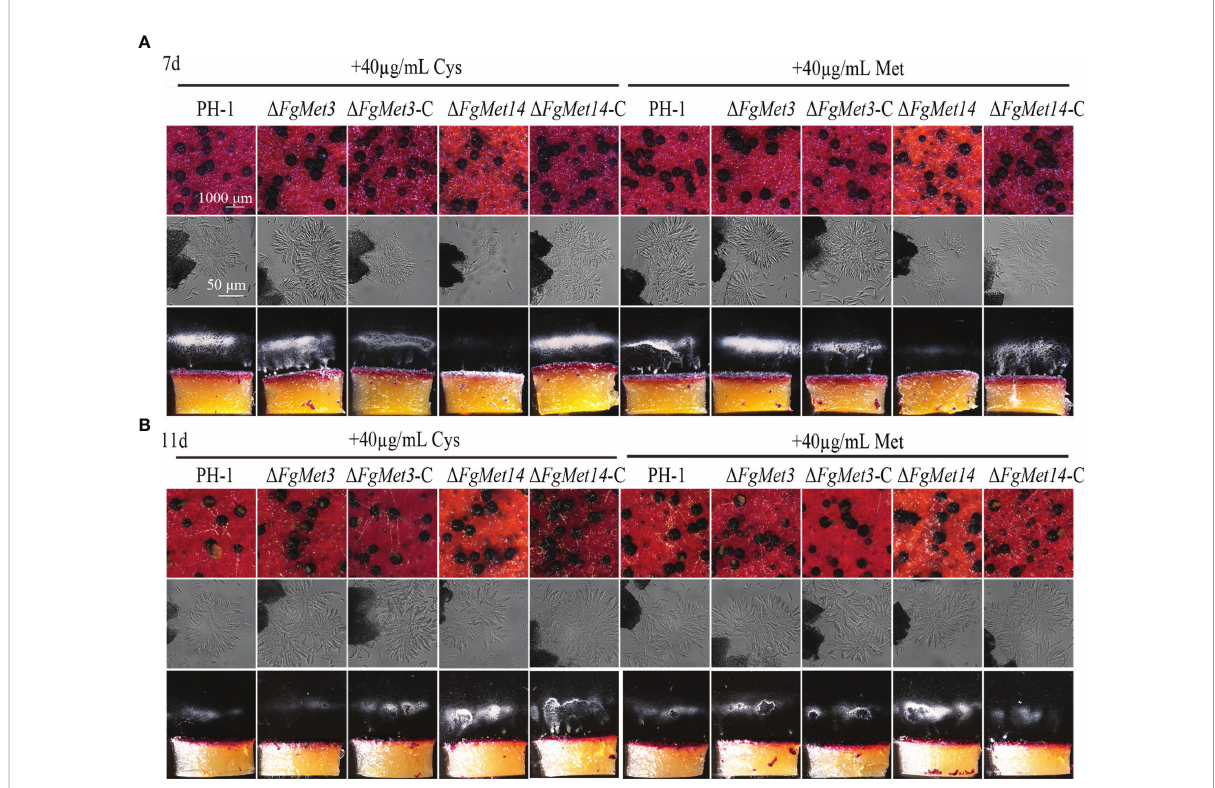
FIGURE 8 Exogenous addition of cysteine and methionine could partially restore the sexual reproductive ability of FgMet3 and FgMet14 deletion mutants. (A) The sexual reproduction of strains when incubated on carrot medium which contains 40µg/mL cysteine or methionine for 7 days. (B) The sexual reproduction of strains when incubated on carrot medium which contains 40µg/mL cysteine or methionine for 11